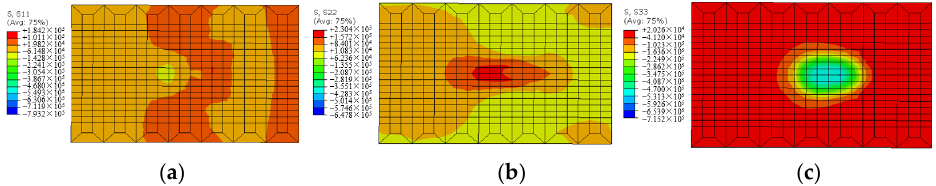
Figure 11. The cloud of the dynamic strains of ART pavement at the speed of 10 km/h. ( a ) Longitudinal. ( b ) Transverse. ( c ) Vertical.